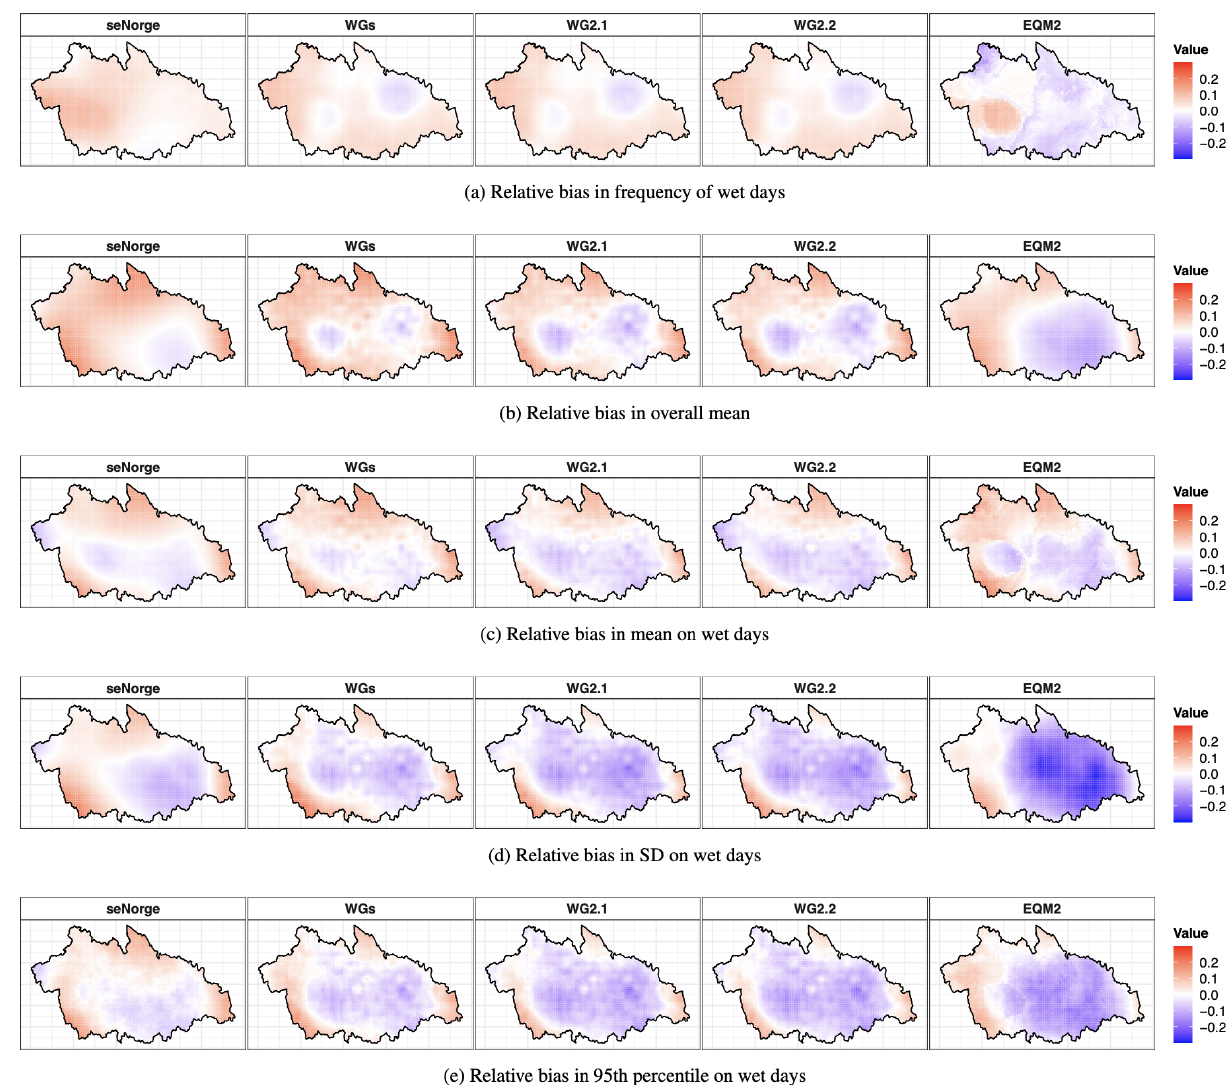
Figure 4. Relative bias in various marginal summary statistics at the 1km × 1km scale in the largest catchment, Gaulfoss. The observed seNorge data in the training period 1957–1986, the stationary WGs simulation, and three simulations using climate change information from RCM2 are compared against the seNorge data in the test period